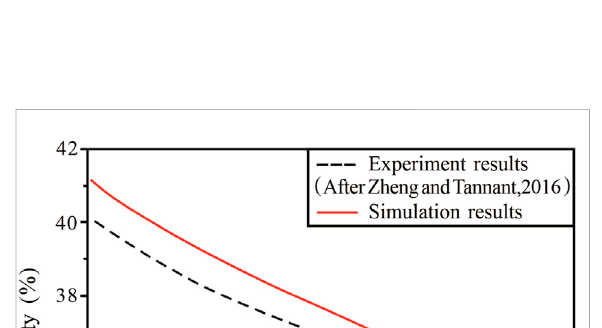
FIGURE 8 Comparison of the PSD curves between the simulation and experiment.